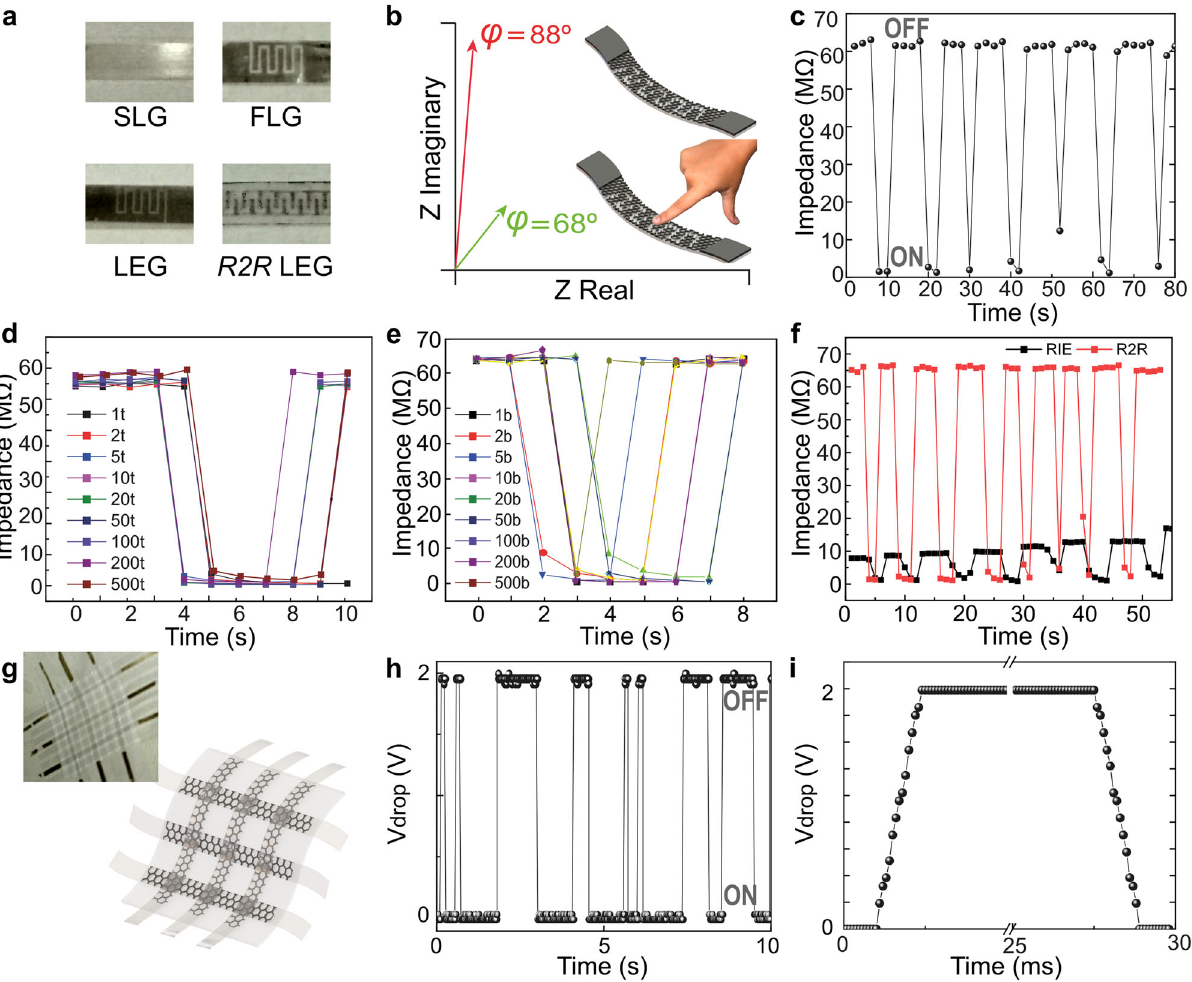
Fig. 2 Touch sensors: a Photographs of sensors with single layer graphene (SLG), few-layer graphene (FLG) fabricated using the roll-to-roll (R2R), solution processed graphene fi lms obtained by liquid-exfoliation blade cut (LEG) and using the R2R compatible method. The LEG sensors using the standard patterning is also shown. b Sketch of the impedance response with and without touching. c Impedance upon touching versus time for fl at FLG device. d Impedance upon touching versus time with repeated touching for FLG device. e Impedance upon touching versus time with repeated bending for FLG device. f Difference in performance between touch sensors patterned using the R2R compatible method and sensors patterned using reactive ion etching (RIE) for LEG. g Photo and schematics of position sensitive arrays. h Voltage drop upon touching vs. time for position sensitive arrays. i Time-resolved rise and fall times upon touching for position sensitive arrays. The various on/off intervals in c , d , e , f , h are due to the difference in the intensity and duration of the user ’ s fi nger touching the inhomogeneity makes it less suitable for sensor purposes. This effect is not shown in LEG with R2R approach because the photoresist prevented graphene deposition. An even simpler and more scalable method was also shown, using blade-cutting to de fi ne the pattern, with results comparable with the R2R method (Supplementary Fig. S7). Transparent and fl exible position-sensitive arrays of graphene- coated fi bres were woven in a squared fabric by orthogonally intertwining conducting fi bres separated by a poly(methyl methacrylate) (PMMA) dielectric layer, thus providing sensitive points at their intersections (Fig. 2g). The sensing mechanism, in this case, is purely self-capacitive, widely used across the electronics industry (Supplementary section S3). The touch- sensing performance, quanti fi ed as the voltage drop across the PMMA layer sandwiched between 2 orthogonal graphene fi bres, is shown in Fig. 2h, with very stable ON/OFF states upon several touches. We analysed the speed of sensing (Fig. 2i) and found a rise and fall times of 1.4 ms regardless the type of graphene used. The rise and fall time of our devices are limited by the electronics